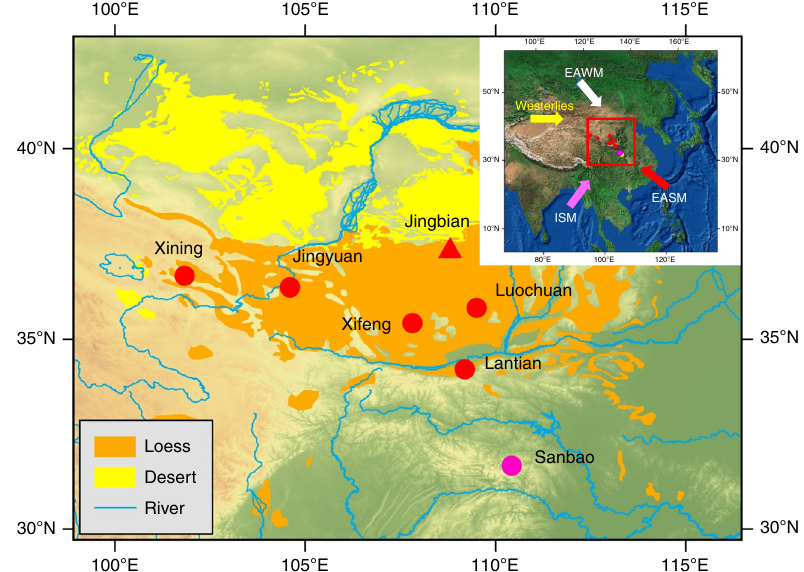
Fig. 1 Map of Chinese Loess Plateau showing surrounding deserts and rivers and location of the ICS stratotype site Jingbian. The Jingbian site location is marked with a fi lled red triangle and other well-known loess sites ( fi lled red circles) and the Sanbao cave site ( fi lled pink circle) are also indicated. Inset shows location of map in China and main prevailing wind directions of East Asian Winter Monsoon (EAWM), East Asian Summer Monsoon (EASM) and Indian Summer Monsoon (ISM). The data set is provided by Data Center for Resources and Environmental Sciences, Chinese Academy of Sciences (RESDC) (http://www.resdc.cn). The base map is a coloured DEM map derived from SRTM 90 m data 84 and the inset map is based on http://www.arcgis. com/home/item.html?id = c3265f30461440c2999add34bcae8e0a. A detailed aerial photograph of the Jingbian site with the studied loess pro fi les ( A , B , C , D , E ) marked is given in Supplementary Fig.